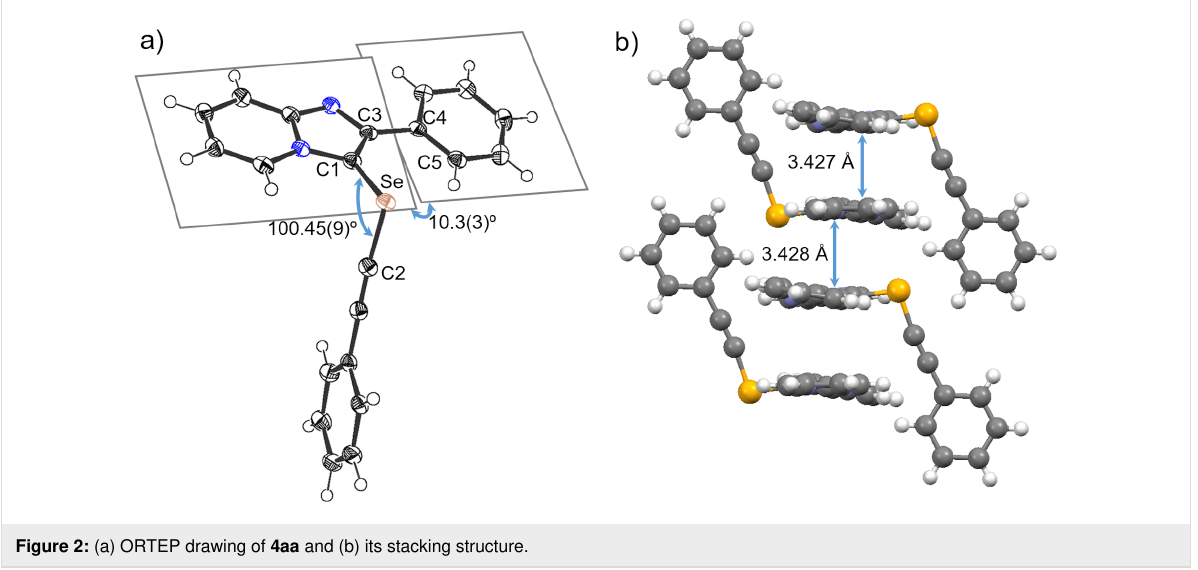
Table 2: One-pot two-step synthesis of alkynyl imidazopyridinyl selenides 4 a .